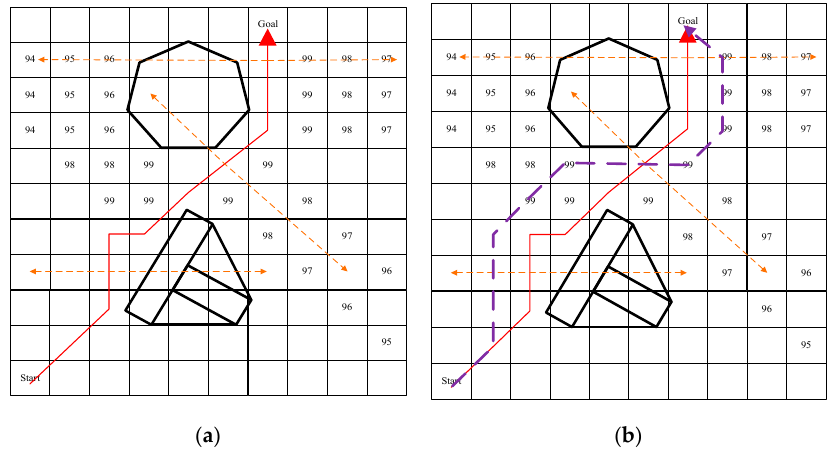
Figure 2. ( a ) Local path planning and grid scores; ( b ) local path planning using the expansion logic strategy.